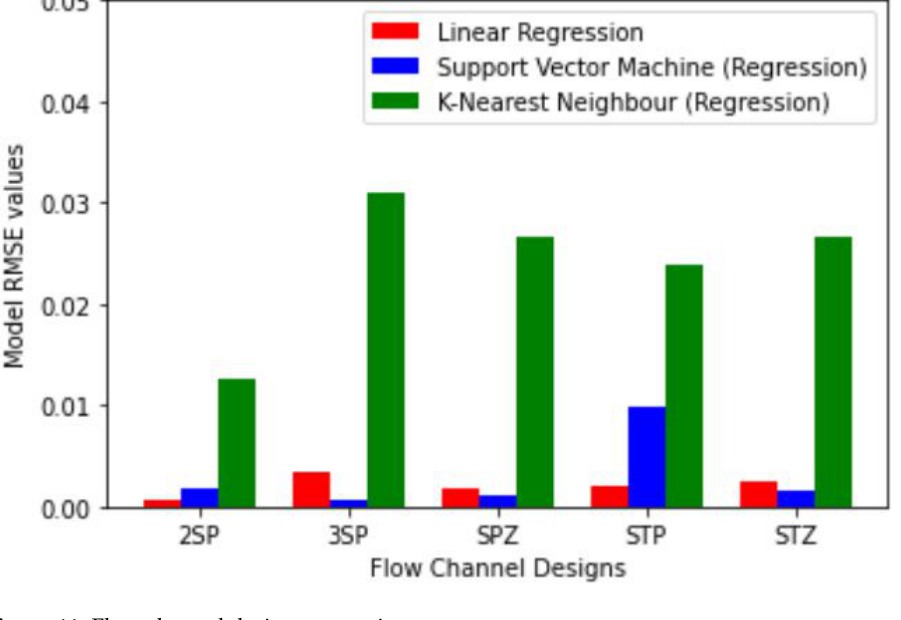
Figure 11. Flow channel design